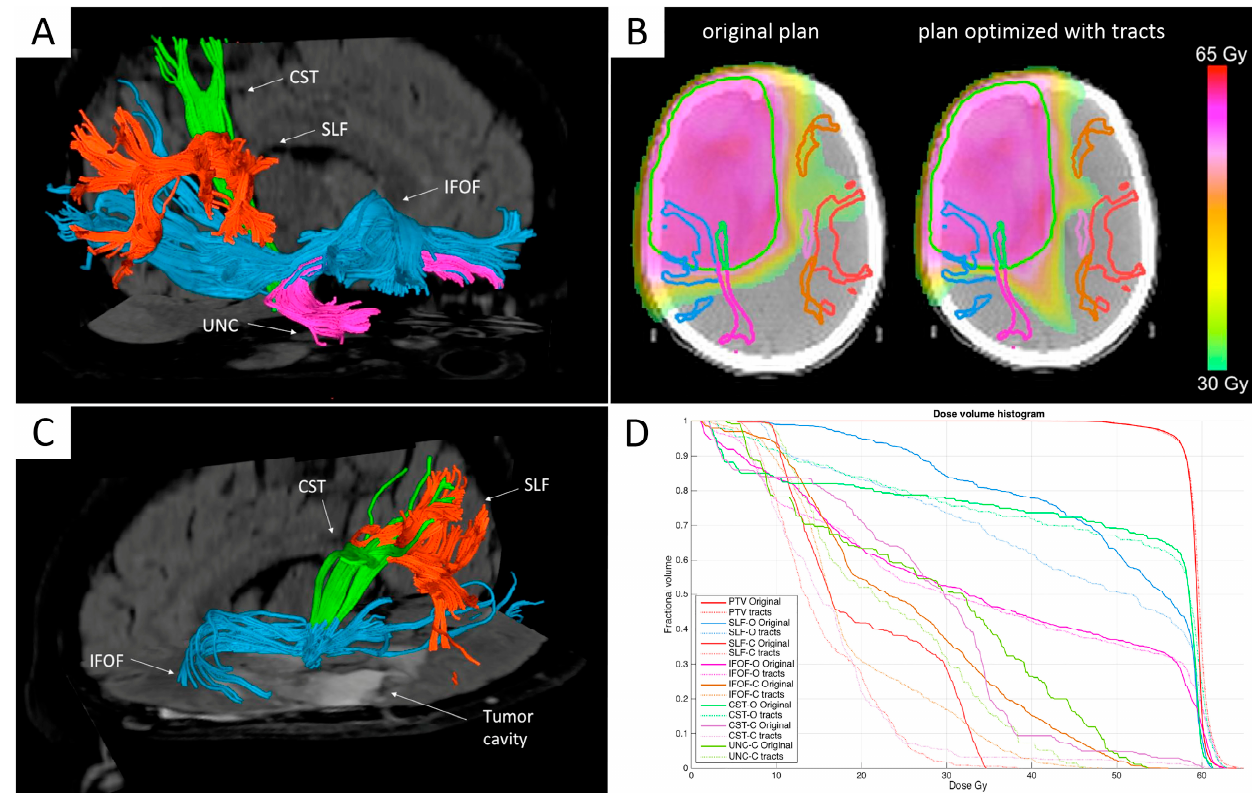
Figure 1. Integration of multiple white matter tracts as depicted by MR Tractography in the tomotherapy RT planning. ( A , C ) Post-surgical MR tractography analysis of a glioblastoma (GBM) patient: The upper image ( A ) shows the reconstructed tracts in the contralateral (healthy) hemisphere, while the lower image ( C ) shows the tracts surrounding the surgical cavity in the ipsilateral (affected) hemisphere. CST = corticospinal tract; IFOF = Inferior fronto-occipital fasciculus; UNC = uncinate fasciculus; SLF = superior longitudinal fasciculus. ( B ) Comparison of dose distributions for the original plan (on the left) and the tract-optimized plan (on the right), showing the different dose conformation outside the target and the preservation of relevant tracts. ( D ). The dose-volume histograms (DVH) data for the two planning modalities in B is shown. DVH for each tract in the original plan is represented with solid lines, while DVH for each tract in the new plan incorporating the fibers is represented with dotted lines. ‘I’ indicates ipsilateral tracts, while ‘C’ indicates contralateral tracts. A significant reduction of the dose delivered to tracts was observed when fibers were included in the optimization process, which was more relevant for contralateral tracts. No significant differences were found in PTV coverage between the original plans and the optimized plans incorporating fiber tracts (solid and dotted red lines). Adapted with permission from